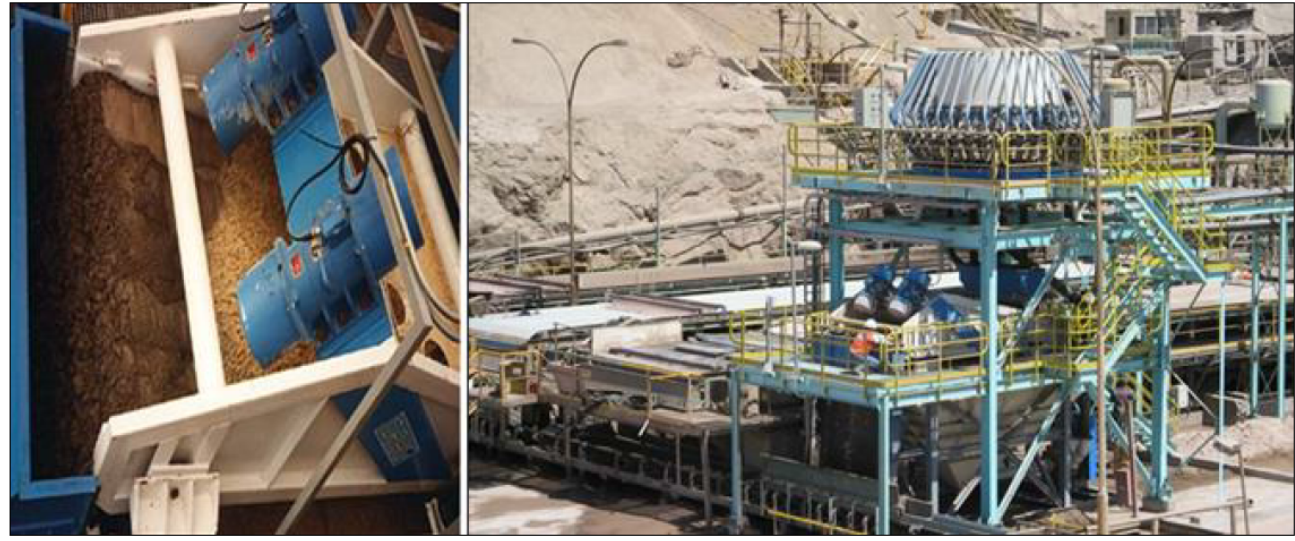
Figure 78. Mantos Blancos Cycloning Plant and Vibratory Screens for Tailings [68].